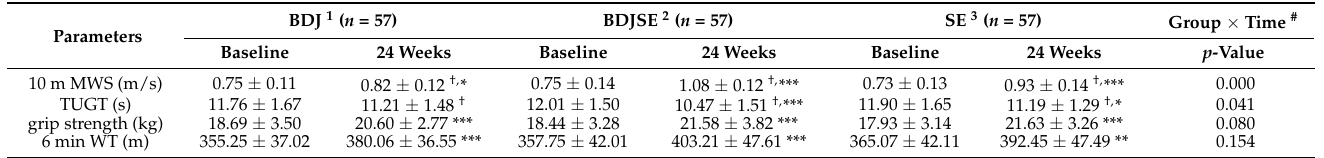
Figure 2. The scatter plot with a rotated kernel density plot on every side. It illustrates the physical capability of the frail elderly at the start and after the intervention. ( a ) 10 m MWS, ( b ) timed up-and- go test, ( c ) grip strength, ( d ) 6 min WT. BDJ denotes Baduanjin group; BDJSE denotes Baduanjin, strength, and endurance group; SE denotes strength and endurance group. * p < 0.05, ** p < 0.01, *** p < 0.001. For the significance of intragroup variations, † shows a significant difference among groups († < 0.05). Table 2. Two-way repeated-measures ANOVA results for each group at baseline and 24 weeks for the test